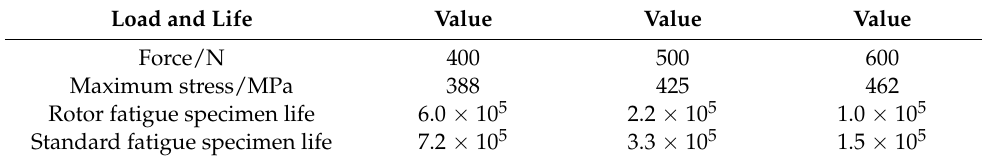
Table 3. Comparison of life between rotor fatigue specimens and standard fatigue specimens. Load and